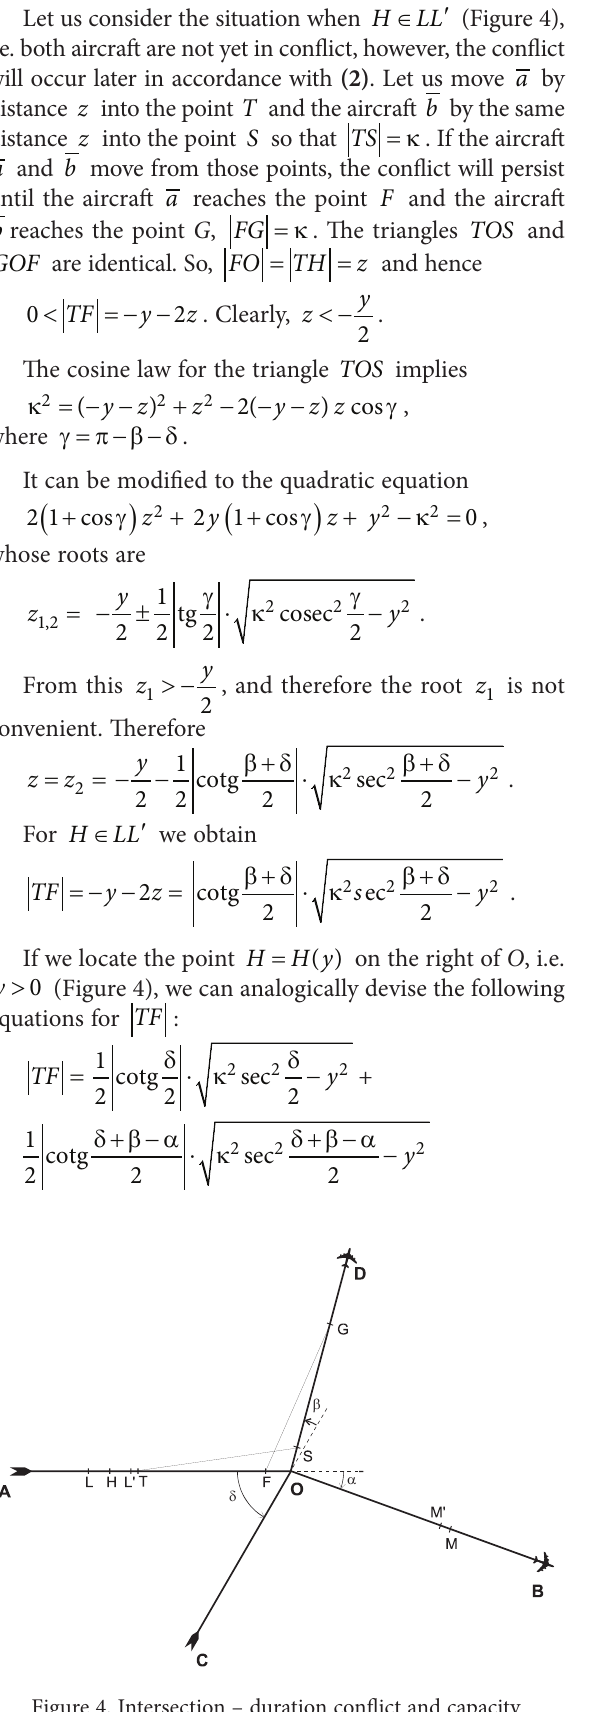
Figure 4. Intersection – duration conflict and